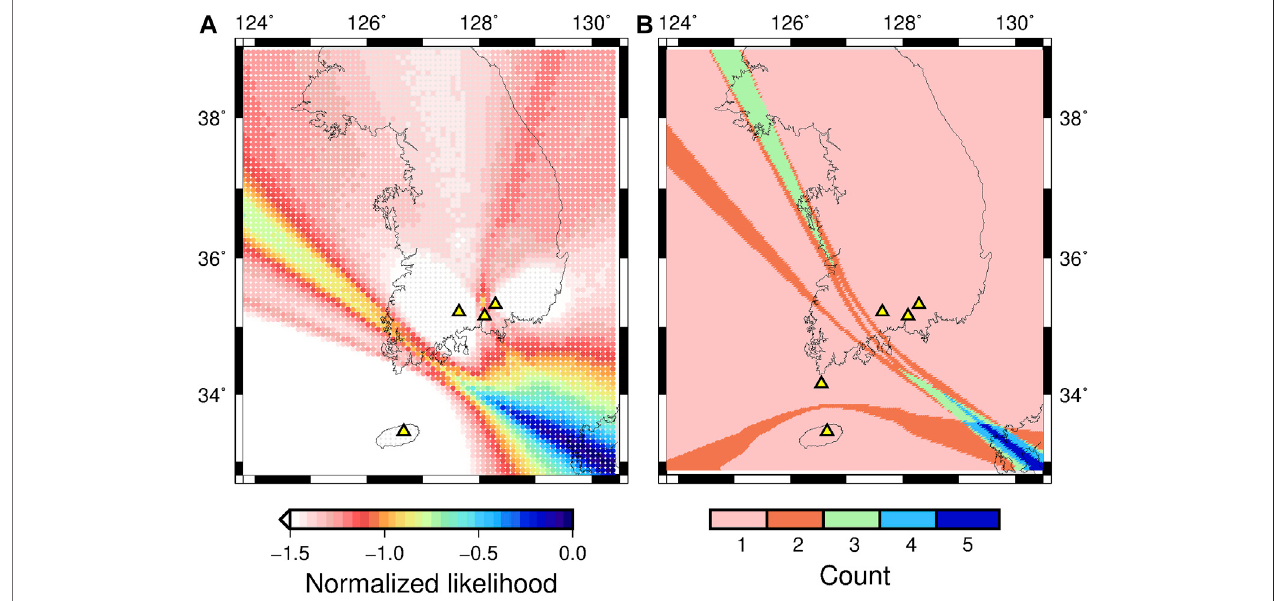
FIGURE 5 | Snapshots of the association grid of (A) normalized likelihood distribution computed by binder_max and (B) count of EDT surfaces crossing each grid by binder_ew . Thepicks ofthe mostsoutheastevent in Figure 3A are used forthe association.Seismic stations triggered arerepresented byyellow triangles.Note that binder_max discardedthisgroupofthepicksbecausethelocationofthemaximumlikelihoodliesontheedgeofthegridboundary;incontrast, binder_ew initiatedthisas an event because the center of the grids with the maximum count lies inside the grid.